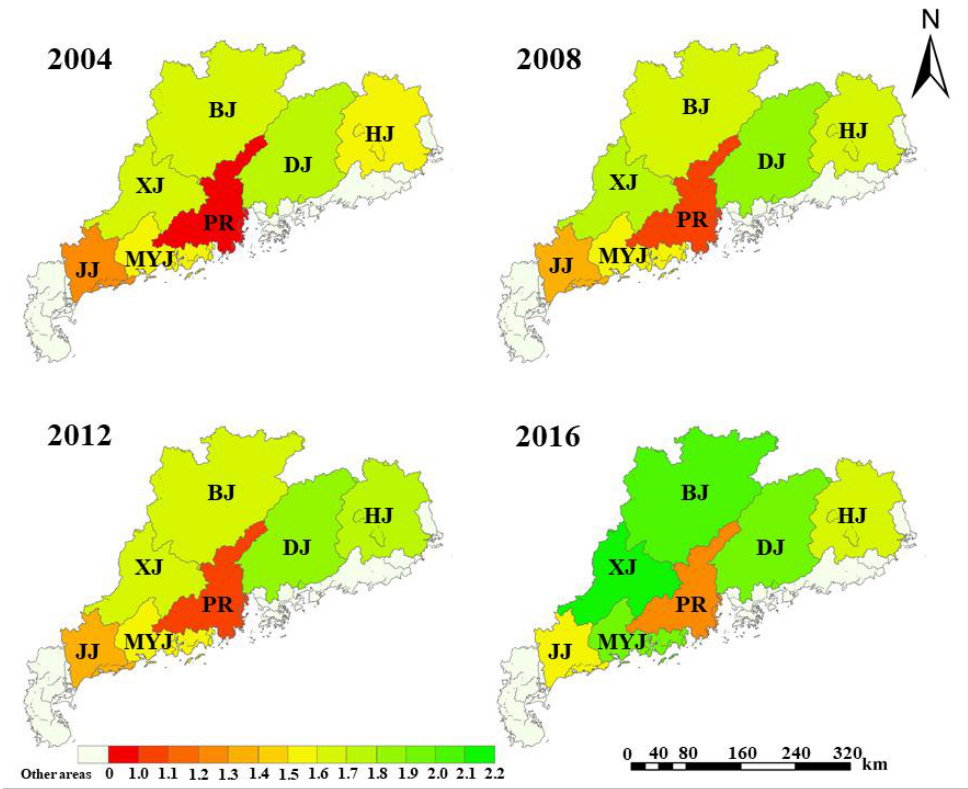
Figure 5. Spatial patterns of the annual mean LAI in the seven major basins in Guangdong.